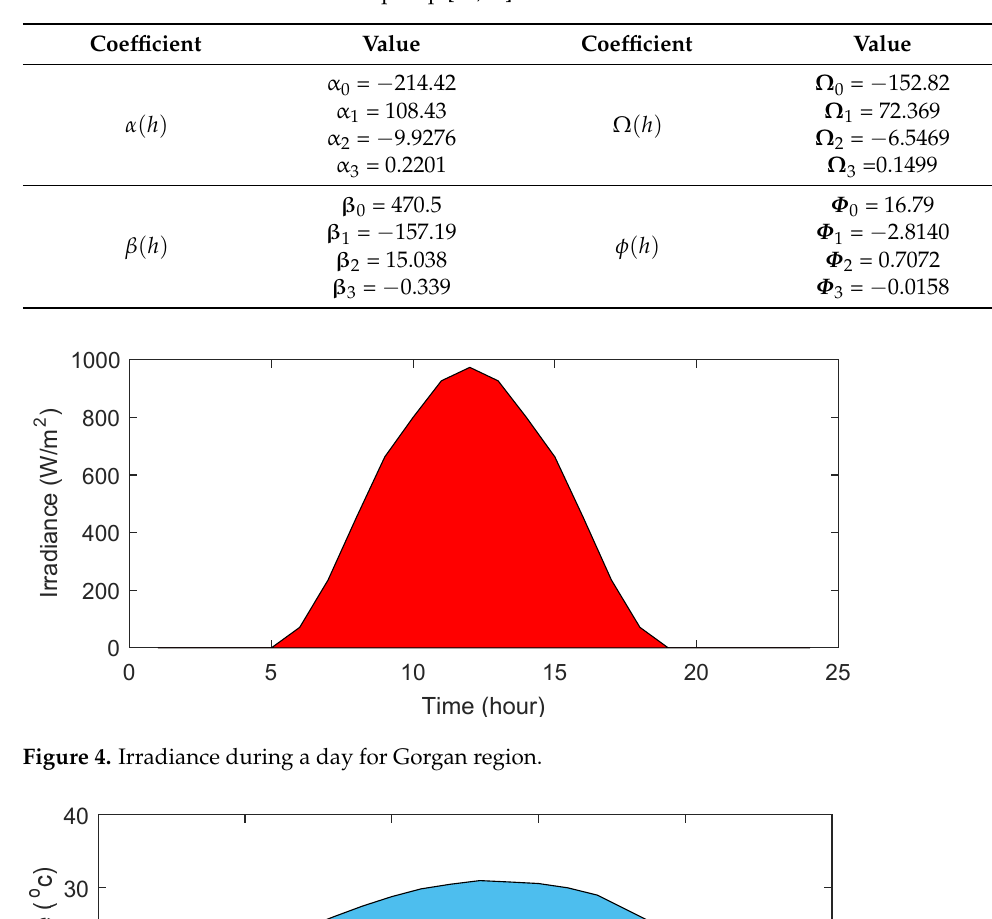
Table 5. Coefficients value of motor pump [12,13].